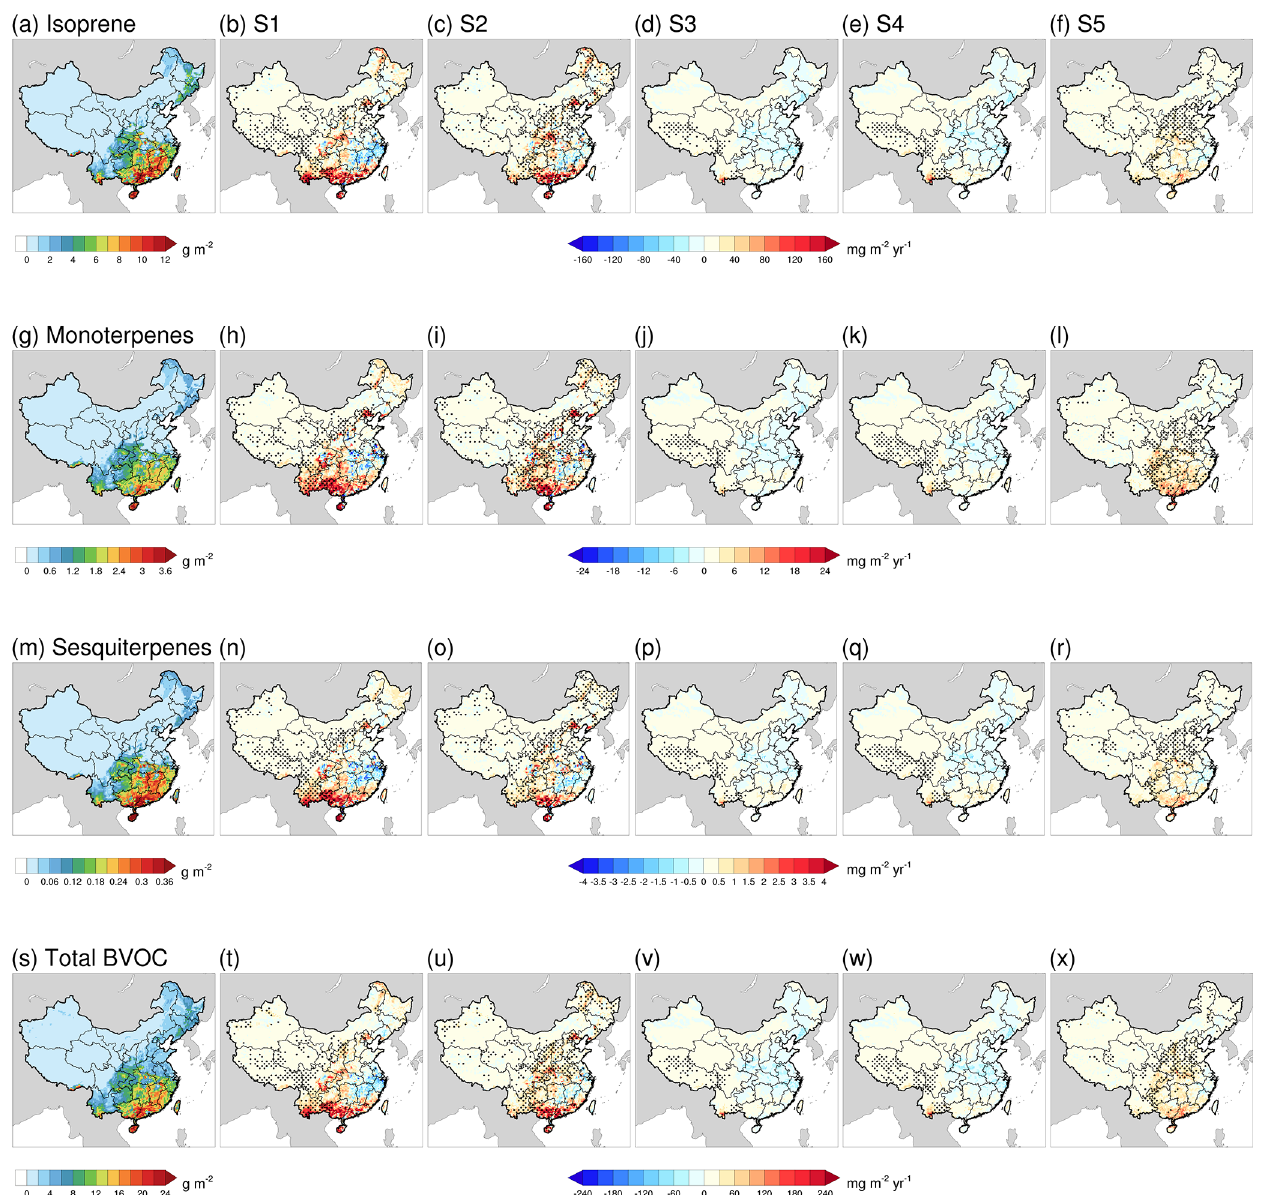
Figure 5. The horizontal distributions of isoprene, monoterpenes, sesquiterpenes and total BVOCs emissions of China in 2001 are shown in panels (a) , (g) , (m) and (s) , respectively. The rest of the rows present the changing trend of isoprene (b–f) , monoterpenes (h–l) , sesquiterpenes (n–r) and total BVOCs (t–x) in S1, S2, S3, S4 and S5, respectively. The Mann–Kendall test was used to mark the grids where p is smaller than